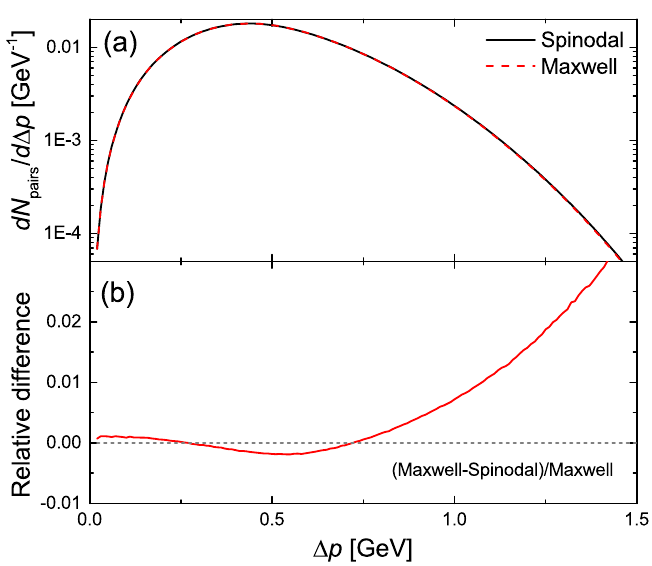
Figure 5 . Panel a : the distribution of the momentum di(cid:11)erence between baryon pairs after the Cooper-Frye hadronization procedure; both, the spinodal and Maxwell distributions, are very similar. Panel b : the small relative di(cid:11)erence between the distributions.